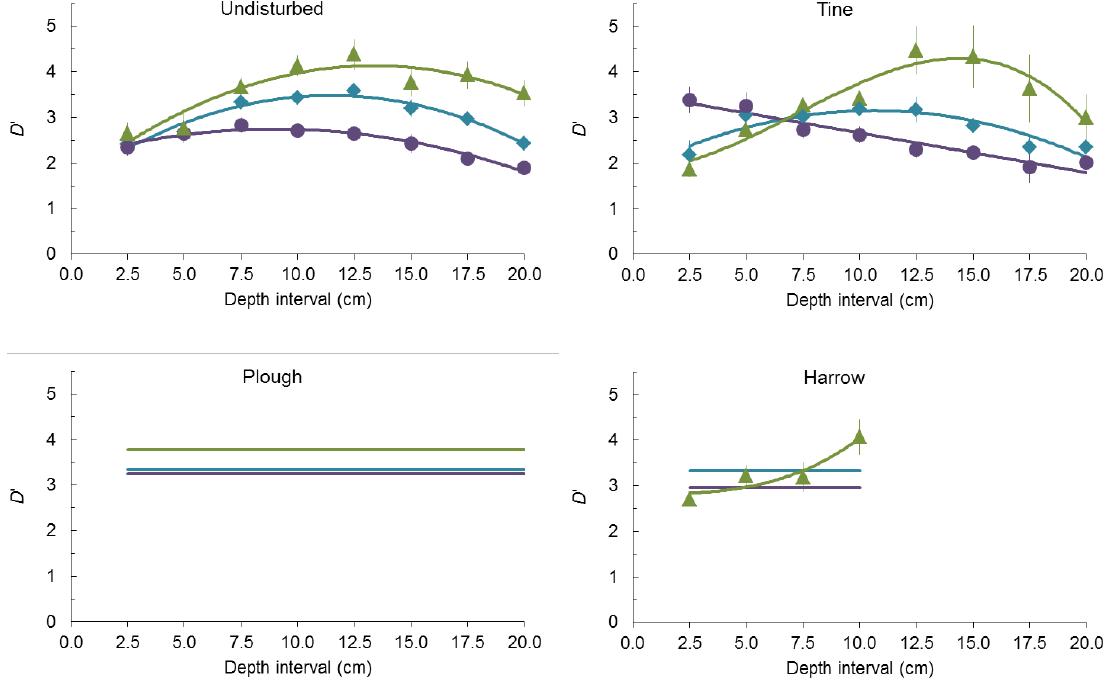
Figure 5. Relationship between D ’ or the larger D ’ (mean ± SE) and 2.5 cm depth intervals before tillage (undisturbed) and after tine, harrow or